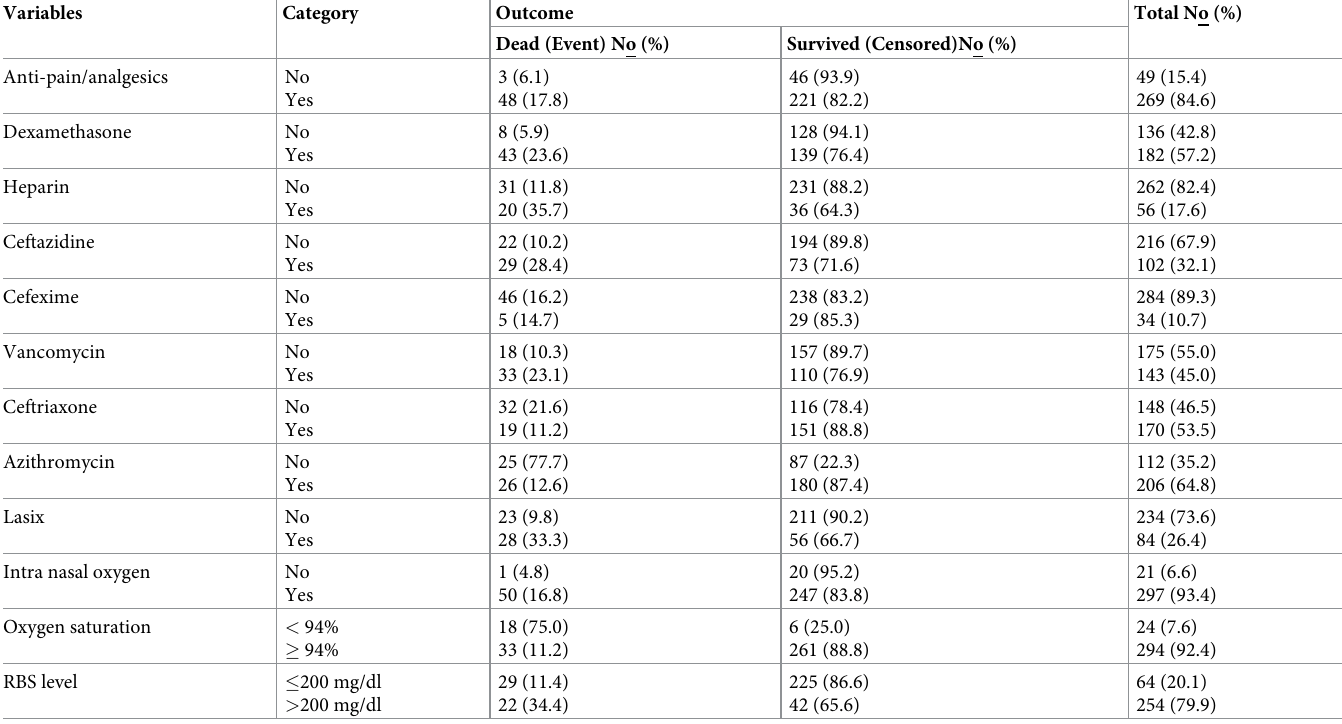
Table 3. Types of medication prescribed for patients admitted with COVID-19 cases in WURH, Western